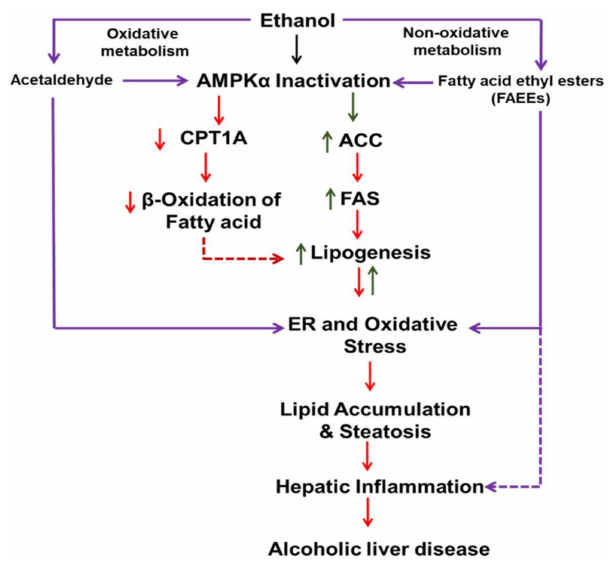
Figure 7. Schematic presentation showing the metabolic basis of EtOH-induced liver injury and the role of dysregulated AMPK α signaling and ER